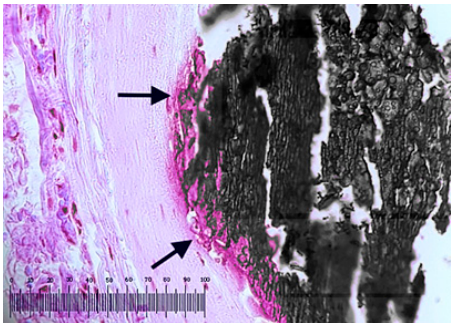
Figure 13. Plaque of calcified atheroma (marked by arrows); the take-off is from the stent vessel wall upstream of it; hematoxylin–eosin staining; magnification × 200.